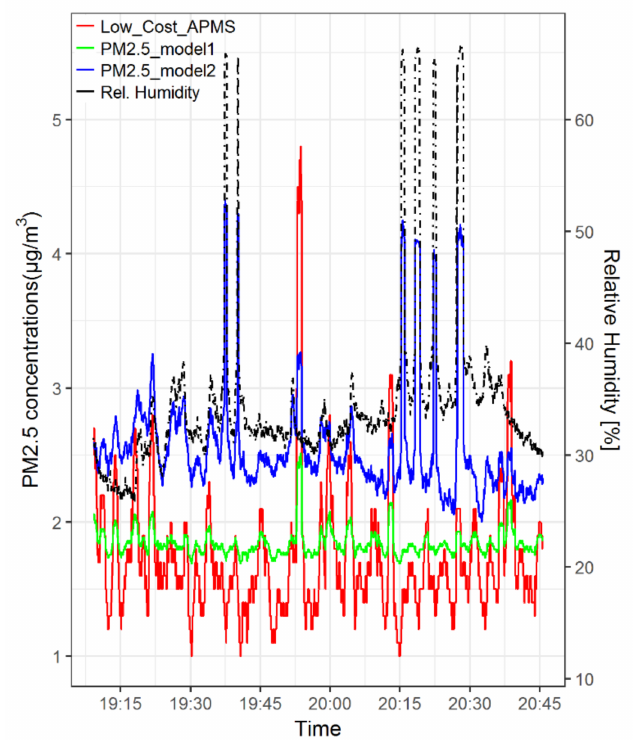
Figure 13. Time series of PM2.5 concentrations with 1 min resolution and relative humidity measurements from the e-bike run in Mons, Belgium on 6 August 2017. The two fitted linear regression models are compared with the raw measurements of the low-cost PM2.5